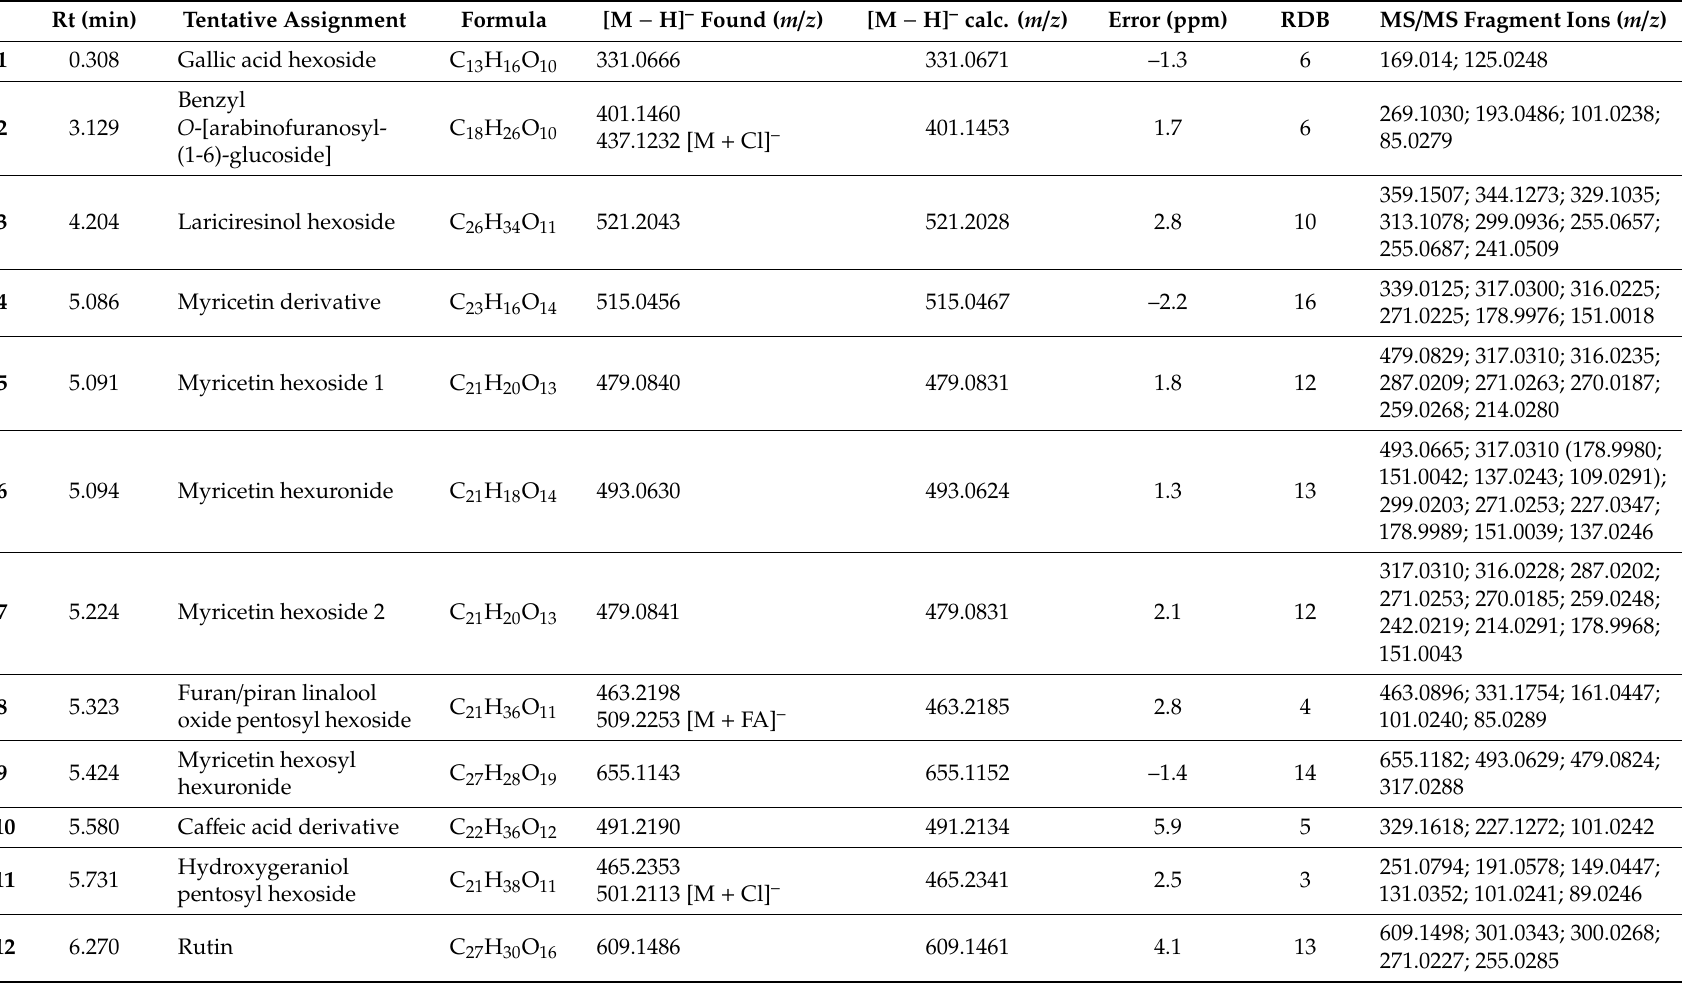
Table 1. Metabolites tentatively identified in the GrM